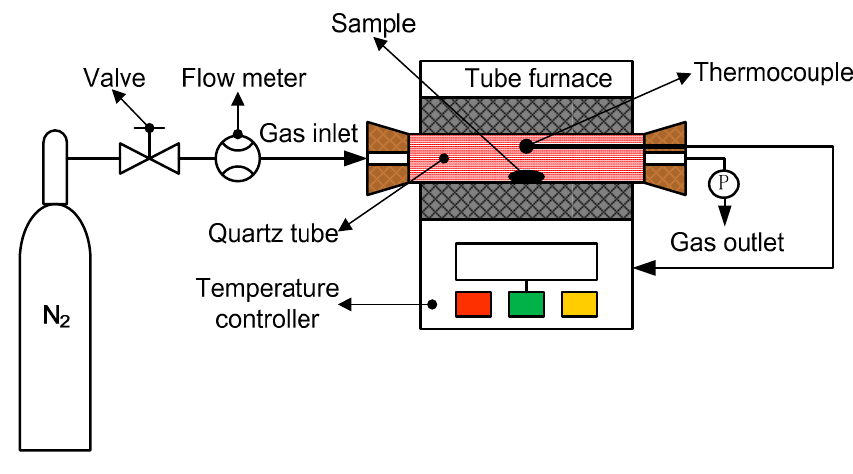
Figure 1. Schematic experimental apparatus.